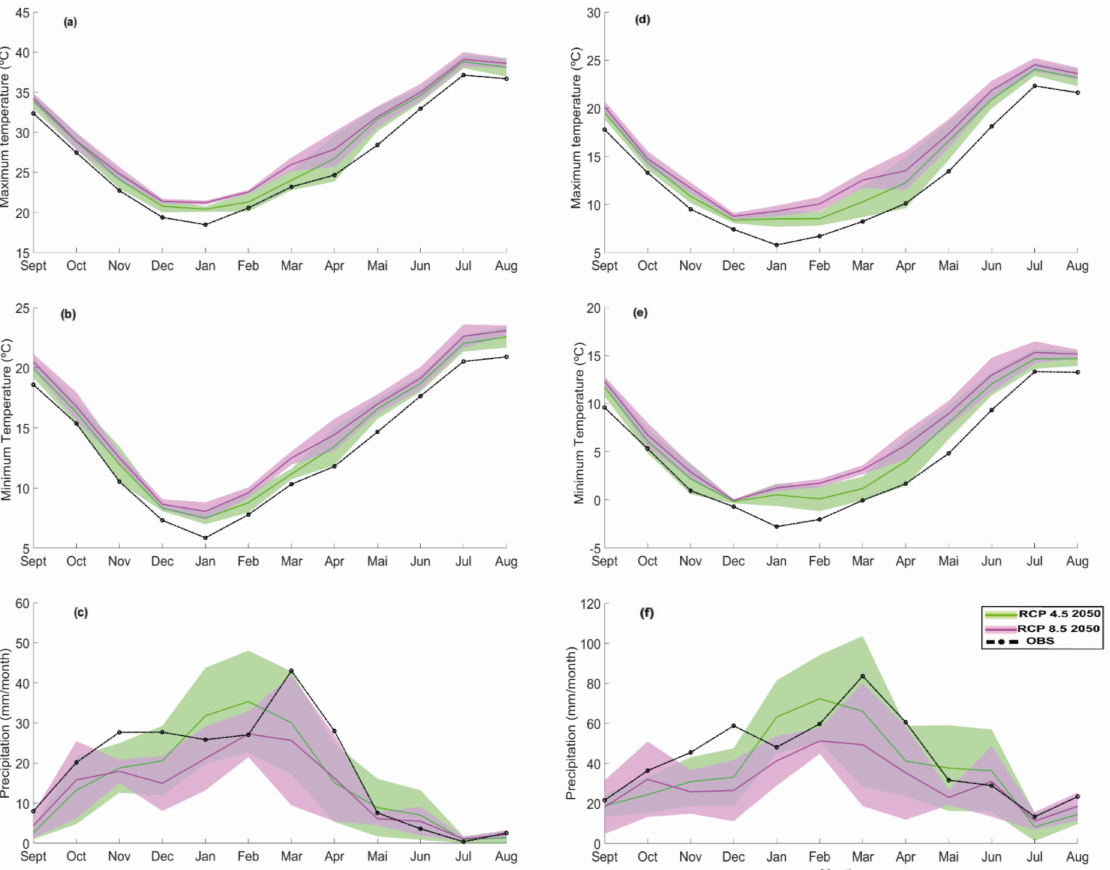
Figure 7. The future projections of minimum and maximum temperature and precipitation at the Marrakech ( left ) and Oukaimeden_CAF ( right ) stations according to the two scenarios RCP4.5 and RCP8.5 for 2041–2060. The lines represent the mean of the models and the hatched section corresponds to the mean ± standard deviation of the 4 RCM models; ( a , d ) maximum air temperature; ( b , e ) minimum air temperature; ( c , f )